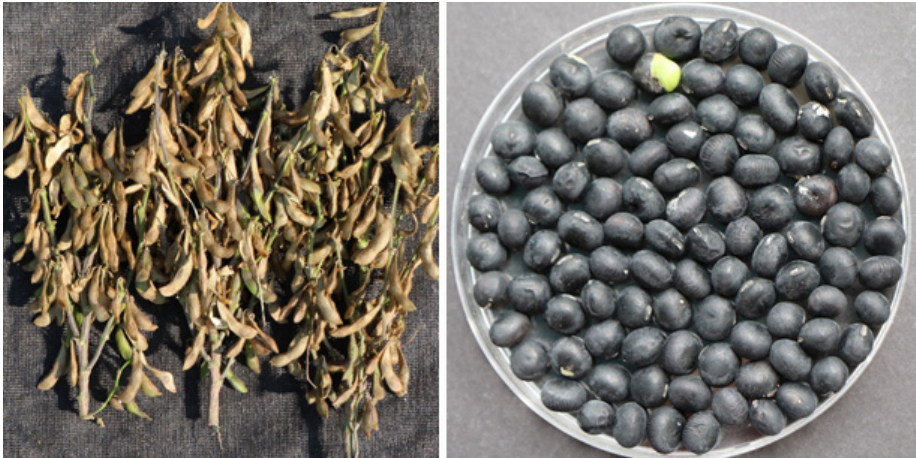
Figure 3. Appearance of the F 4 plant and F 5 seeds with the tetra null allele ( lox1lox2lox3 / lox1lox2lox3 - ti / ti - le / le - rs2 / rs2 ), a black seed coat, and green cotyledon. The seed of the breeding line has a black hilum and a black seed coat color. The cotyledon color of mature seeds is green.